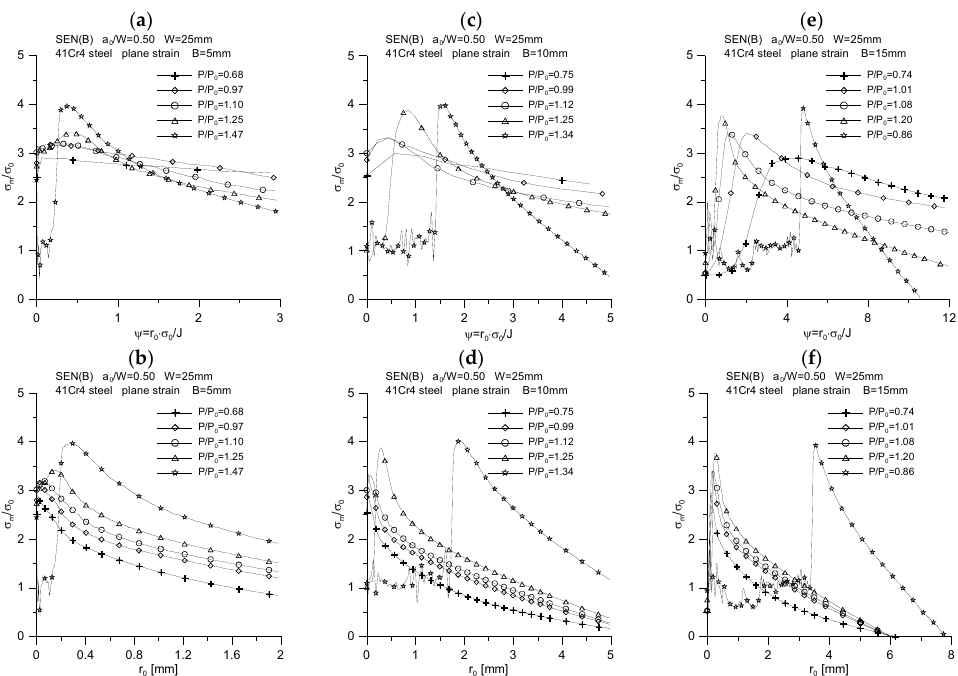
Figure 8. The distribution of mean stresses, σ m / σ 0 , for three specimens used in the crack propagation simulation. The graphs ( a , c , e ) were made for the normalized distance from the crack tip, ψ = r 0 ∙ σ 0 / J , while the graphs ( b , d , f ) were prepared for the physical distance from the initial crack tip position, r 0 . The figures show the distributions for the characteristic moments provided in Table 2. Figure 9 shows the distributions of the stress triaxiality coefficient defined for the characteristic moments provided in Table 2, defined as (cid:3097) (cid:3299)(cid:3299) . The graphs indicate that (cid:3435)(cid:3097) (cid:3300)(cid:3300) (cid:2878)(cid:3097) (cid:3301)(cid:3301) (cid:3439) some of the curves are characteristic of the significant crack length increases observed in experimental tests [5,6]. In close proximity to the crack tip, the value of the triaxiality co ‐ efficient is equal to 0.5, then as you move away from the fracture tip, the triaxiality coeffi ‐ cient decreases to a value equal to the Poisson’s coefficient, i.e., 0.3. It should be noted that the graphs of changes in the value of the stress triaxiality coefficient have a different char ‐ acter, depending on whether they are plotted as a physical function or a normalized dis ‐ tance from the crack tip. It is left to the reader to interpret this conclusion. Figure 10 shows the changes of effective stresses calculated according to the HMH hypothesis, with increasing external load and moving away from the crack tip. Near to the crack tip, values of effective stresses at the level of σ eff = 3.0 ∙ σ 0 are observed, and then as you move away from the crack tip, the value of effective stresses drops to the level equal to the yield point. The value of effective stresses equal to or greater than the yield point means that the material in front of the crack is fully plasticized. The decrease in the value of effective stresses below the yield point, visible in Figure 10b,d,f, means that the material has not plasticized yet. The reader can confront these graphs with the appropriate distributions of plastic zones, which are shown in Figures 4–6, drawing conclusions indi ‐ vidually.